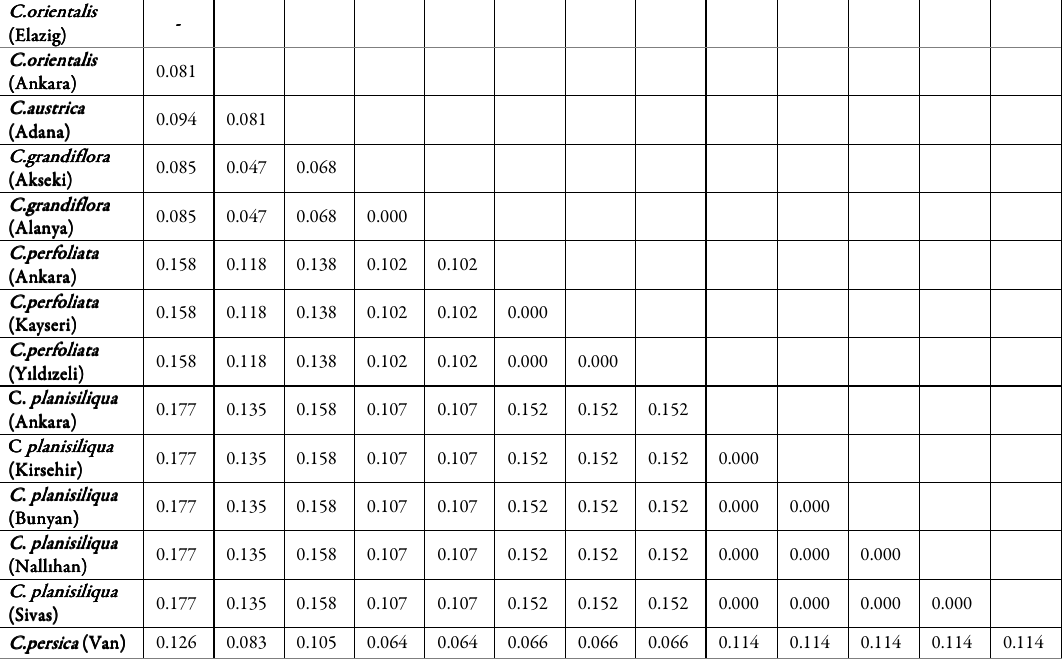
Table 3. Pairwise genetic distance matrix obtained from nrITS sequences